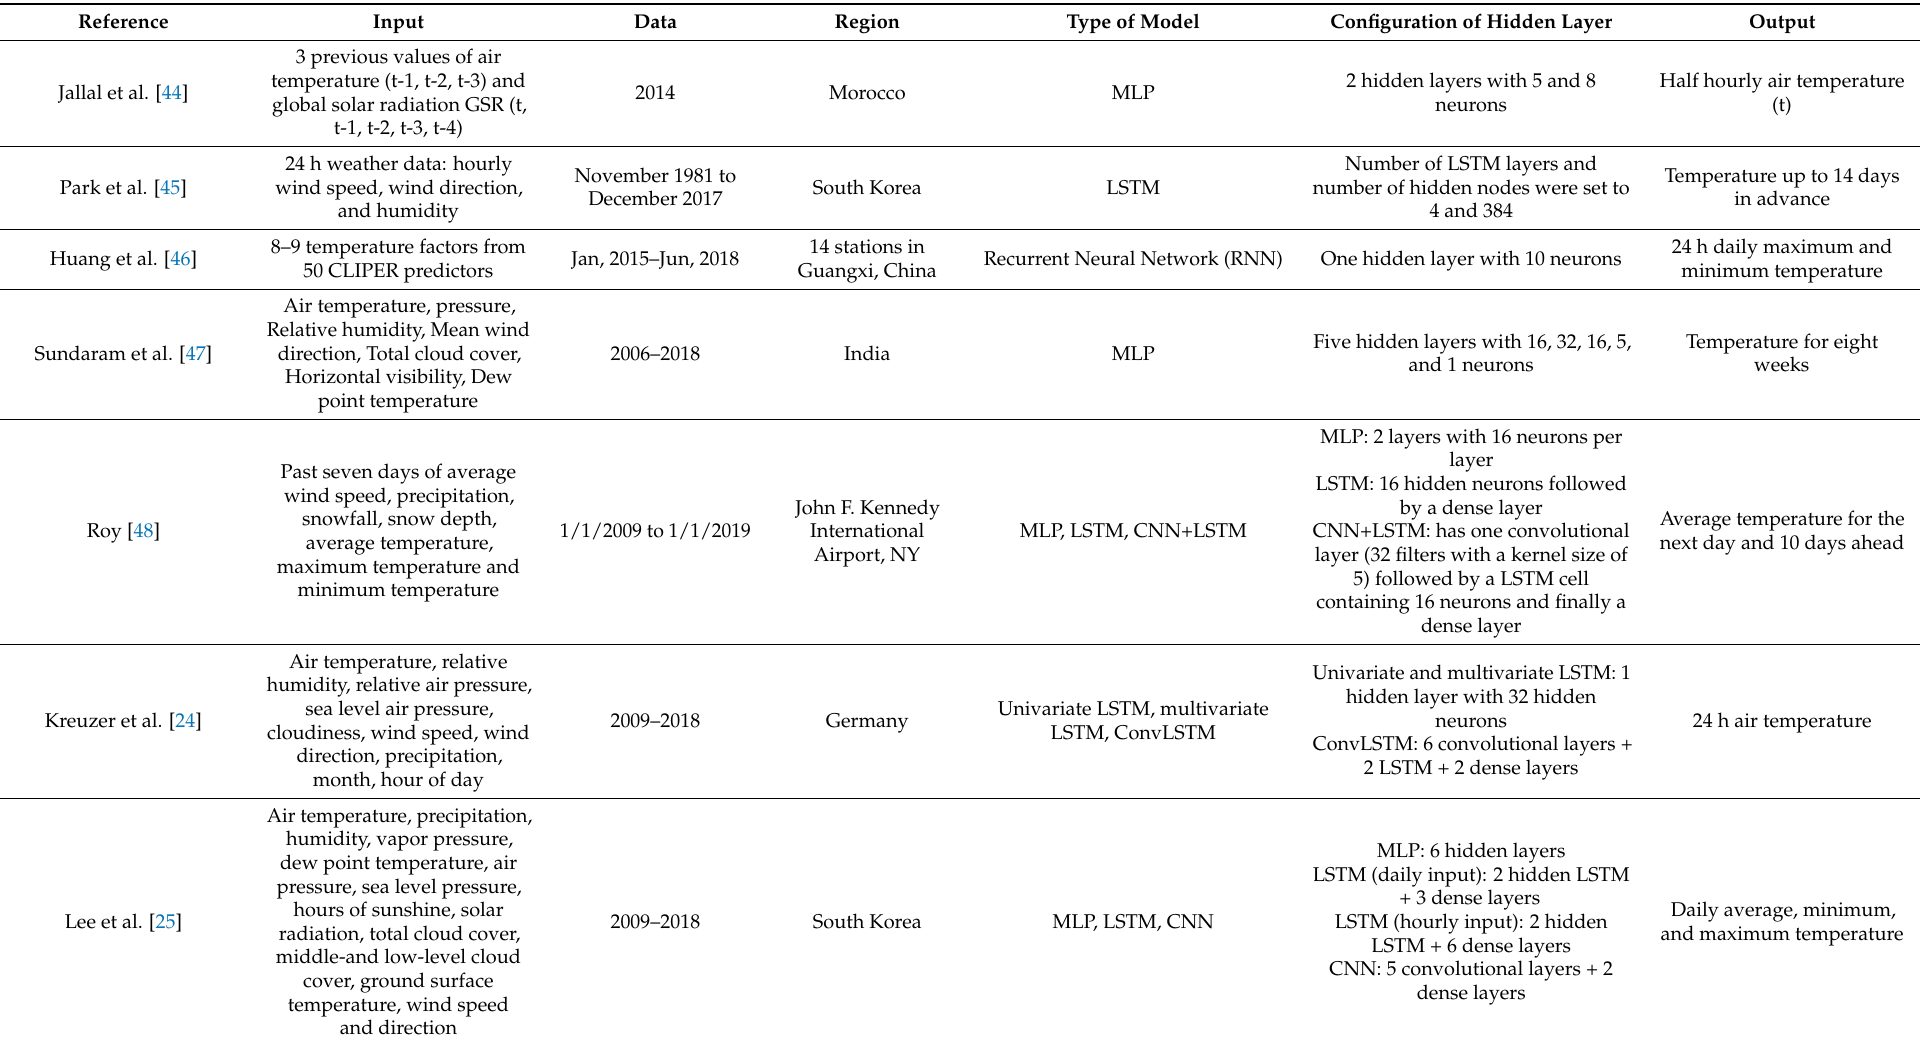
LSTM: 16 hidden neurons followed by a dense